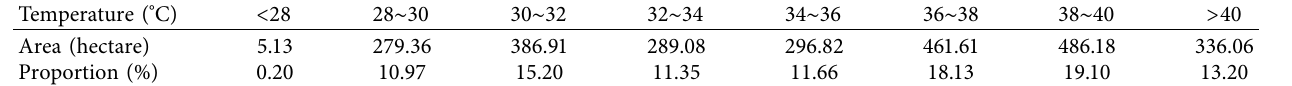
Table 3: Land surface temperature statistics in Xigang District.